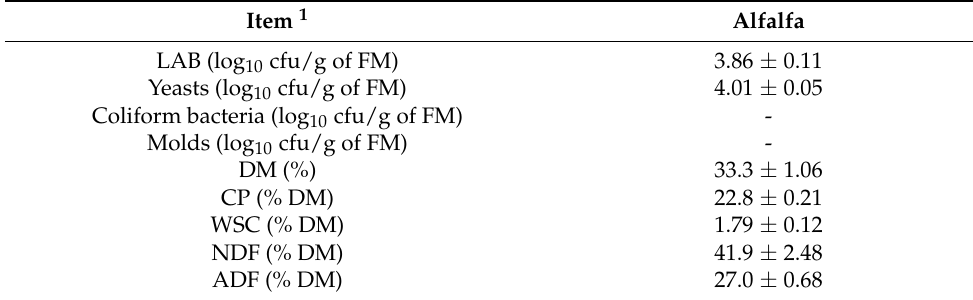
Table 1. Characteristics of alfalfa prior to ensiling (means ± standard deviation).